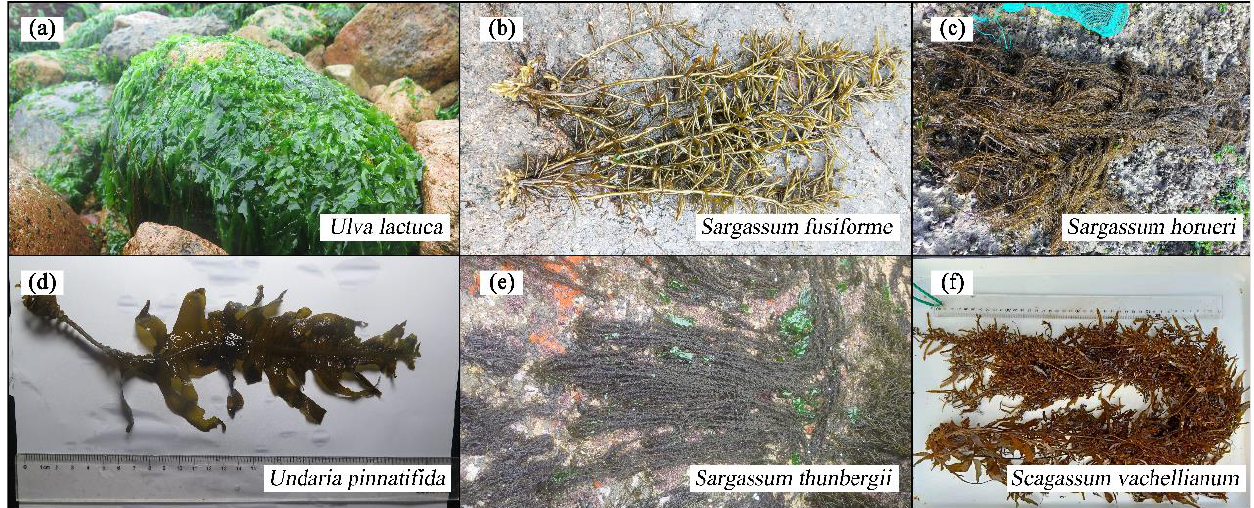
Figure 5. Six representative species in the Ma’an Archipelago. ( a ) Ulva pertusa, ( b ) Sargassum fusiforme, ( c ) Sargassum horneri, ( d ) Undaria pinnatifida, ( e ) Sargassum thunbergii, and ( f ) Sargassum vachellianum.